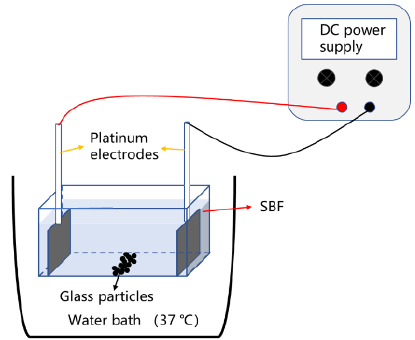
Figure 2. Schematic representation of the experimental setup.